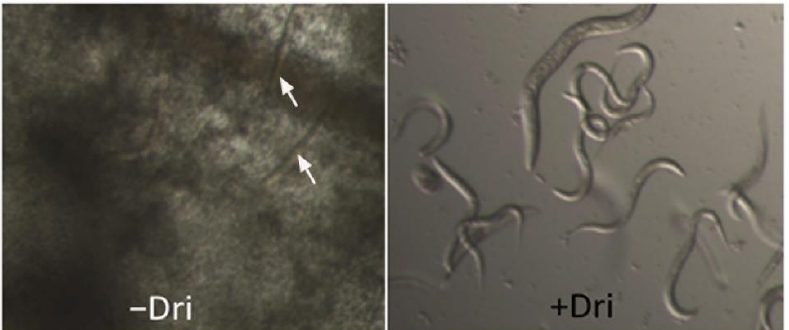
FIGURE 3: Protection of Caenorhabditis elegans worms from C. albicans- mediated death by drimenol (1). C. albi- cans (yeast cells) fed larvae were incubat- ed in RPMI medium without and with 1 (+Dri) (50 µg/ml) in a 96 well microtiter plate and incubated at 30°C for two to three days. Left panel without 1 shows dead worms (straight and immobile, ar- rows) due to C. albicans growth. Right panel shows a well containing 1 where worms were alive as judged by their movements and the lack of fungal